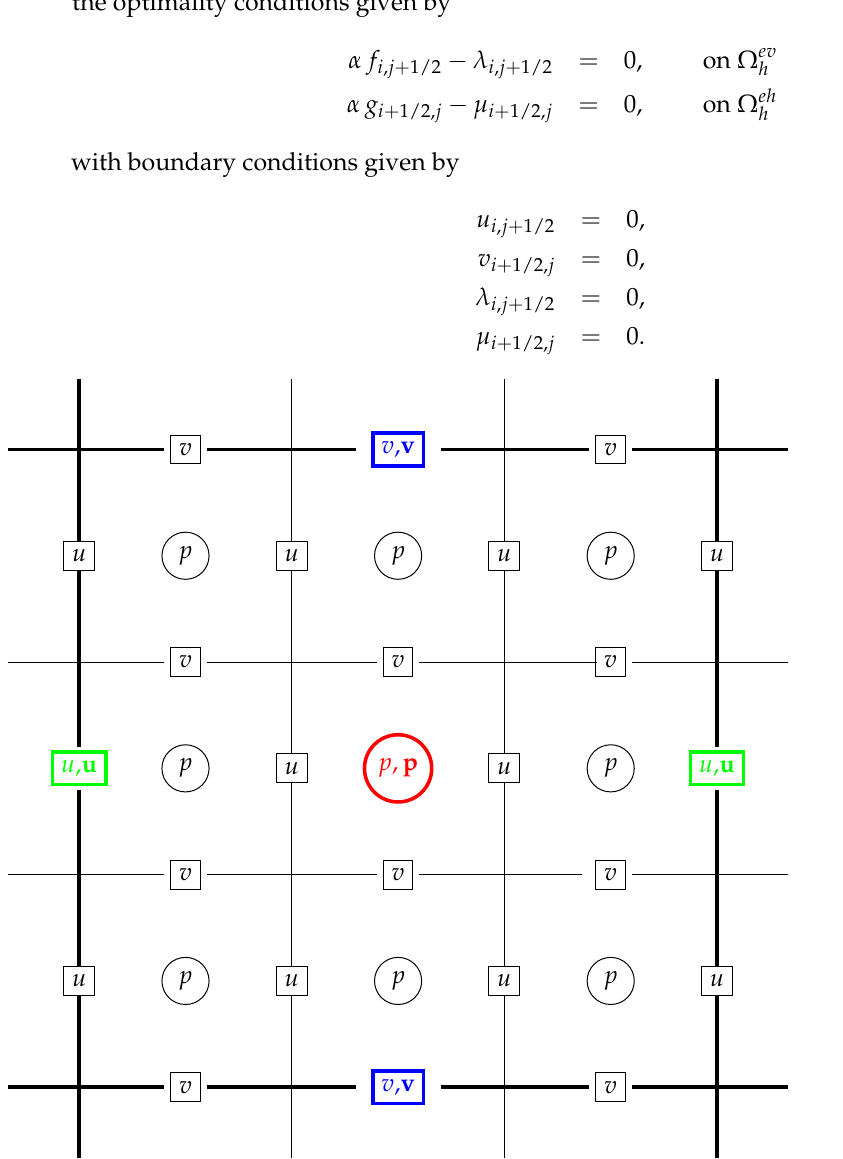
Figure 1. Three-factor coarsening on staggered